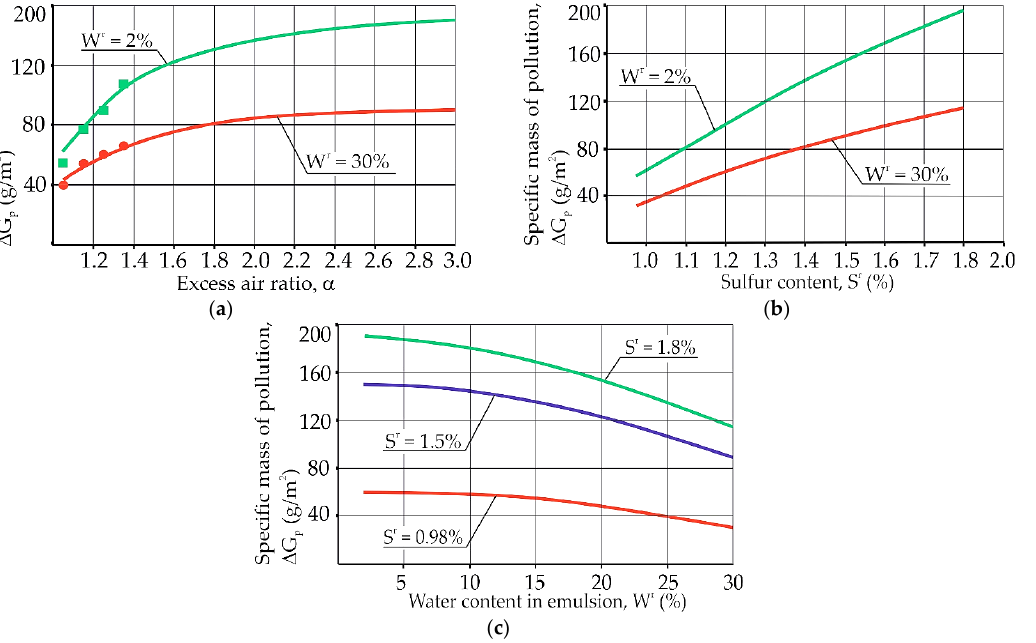
Figure 5. Dependences of the specific mass of pollution G p at: G p = f (α) while S r = 1.5% and W r = 2, 30% ( a ); G p = f (S r ) while α = 2.9 and W r = 2, 30% ( b ); and G p = f (W r ) while α = 2.9 and S r = 0.98, 1.5, and 1.8% ( c ).